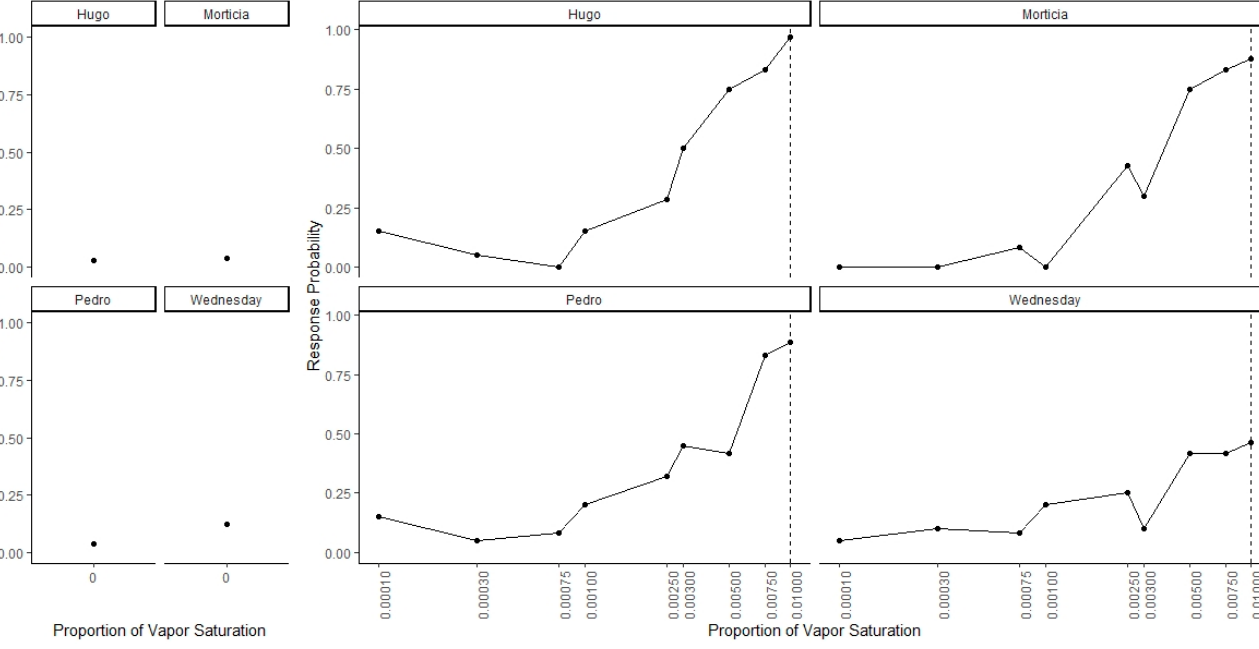
Figure 4. Individual Data for Generalization Test 1. Individual data for all four dogs. Dogs showed similar generalization patterns that reflect the group trends.